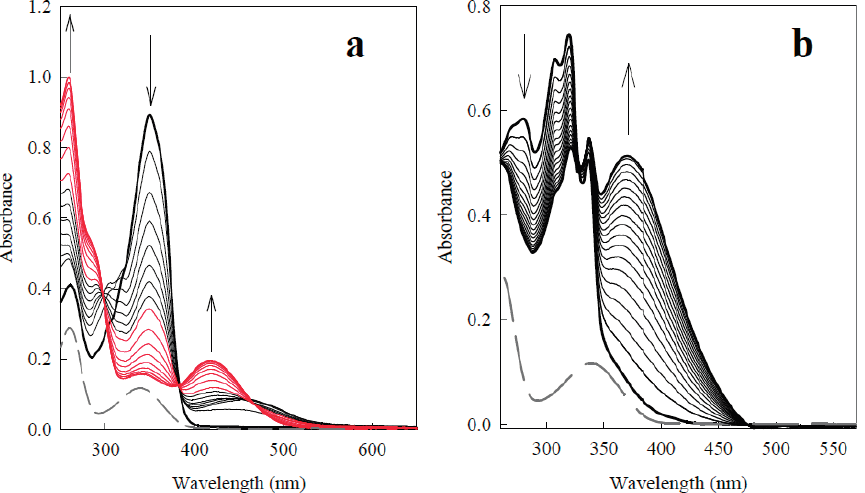
Figure 2. UV-VIS absorbance spectra of reduction of 100 μ M benzofuroxan (Compound 1) ( a ) and reduction of 100 μ M benzodifuroxan (Compound 11) ( b ) in the presence of NADPH-regeneration system (gray dashed curves) by 250 and 50 nM of P-450R, respectively. The spectra of benzofuroxan were recorded every 10 min at the first stage of the reaction (black curves), and subsequently scanned in 20-min intervals (red curves). The reduction of benzodifuroxan was scanned in 4-min intervals. The arrows indicate the directions of absorbance